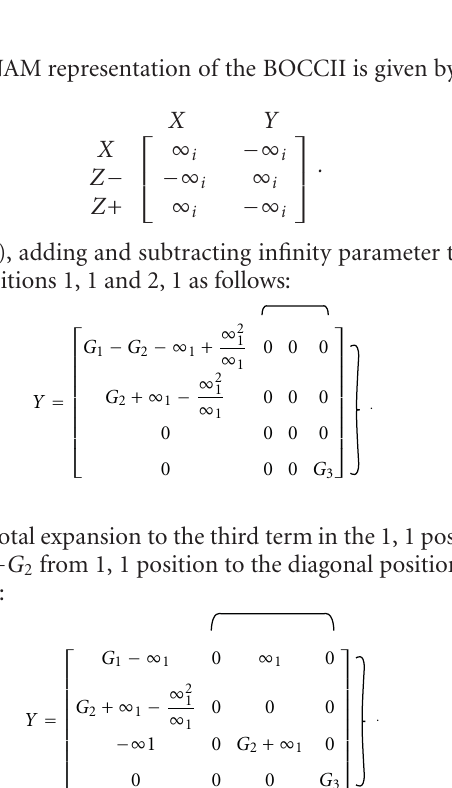
Figure 7: (a) Realization I of class II type B oscillator [17]. (b) Realization II of class II type-B oscillator. (c) Realization III of class II type-B oscillator. (d) Realization IV of class II type-B